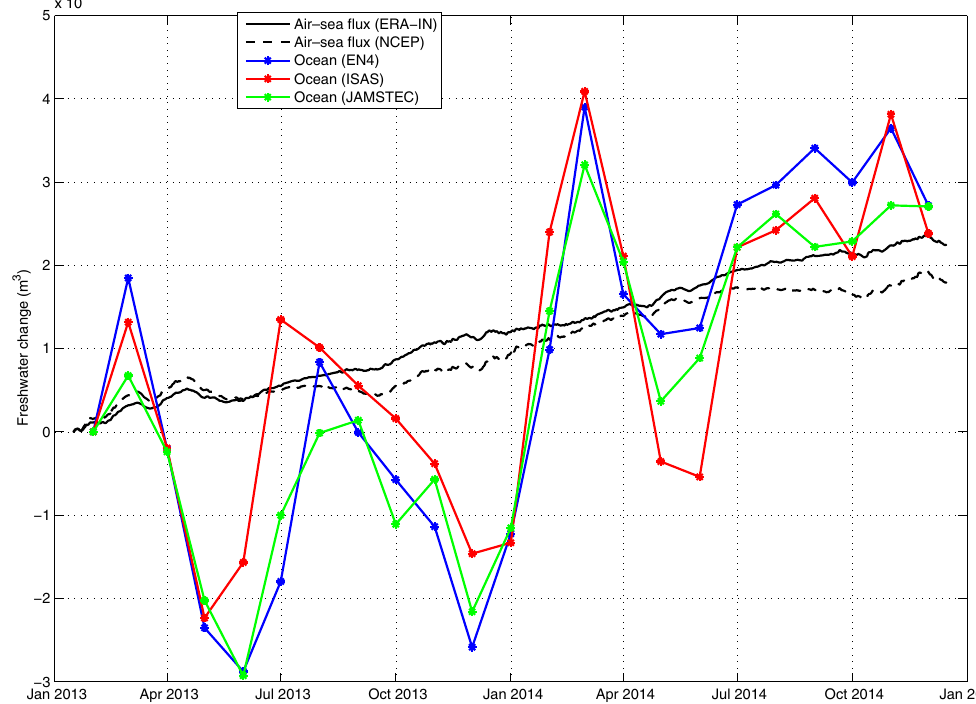
Figure 12. Monthly time series of the freshwater content change between one month and the month before (in m 3 ) accumulated since 1 February 2013 in the upper 1000m of the box delimited by 40–60 ◦ N and 45–10 ◦ W computed from three datasets: EN4 (blue), ISAS (red), and JAMSTEC (green). Integrated air–sea freshwater flux, or precipitation minus evaporation, over the same box and accumulated from 16 January 2013 from ERA-Interim (continuous black line) and from NCEP (discontinuous black line)